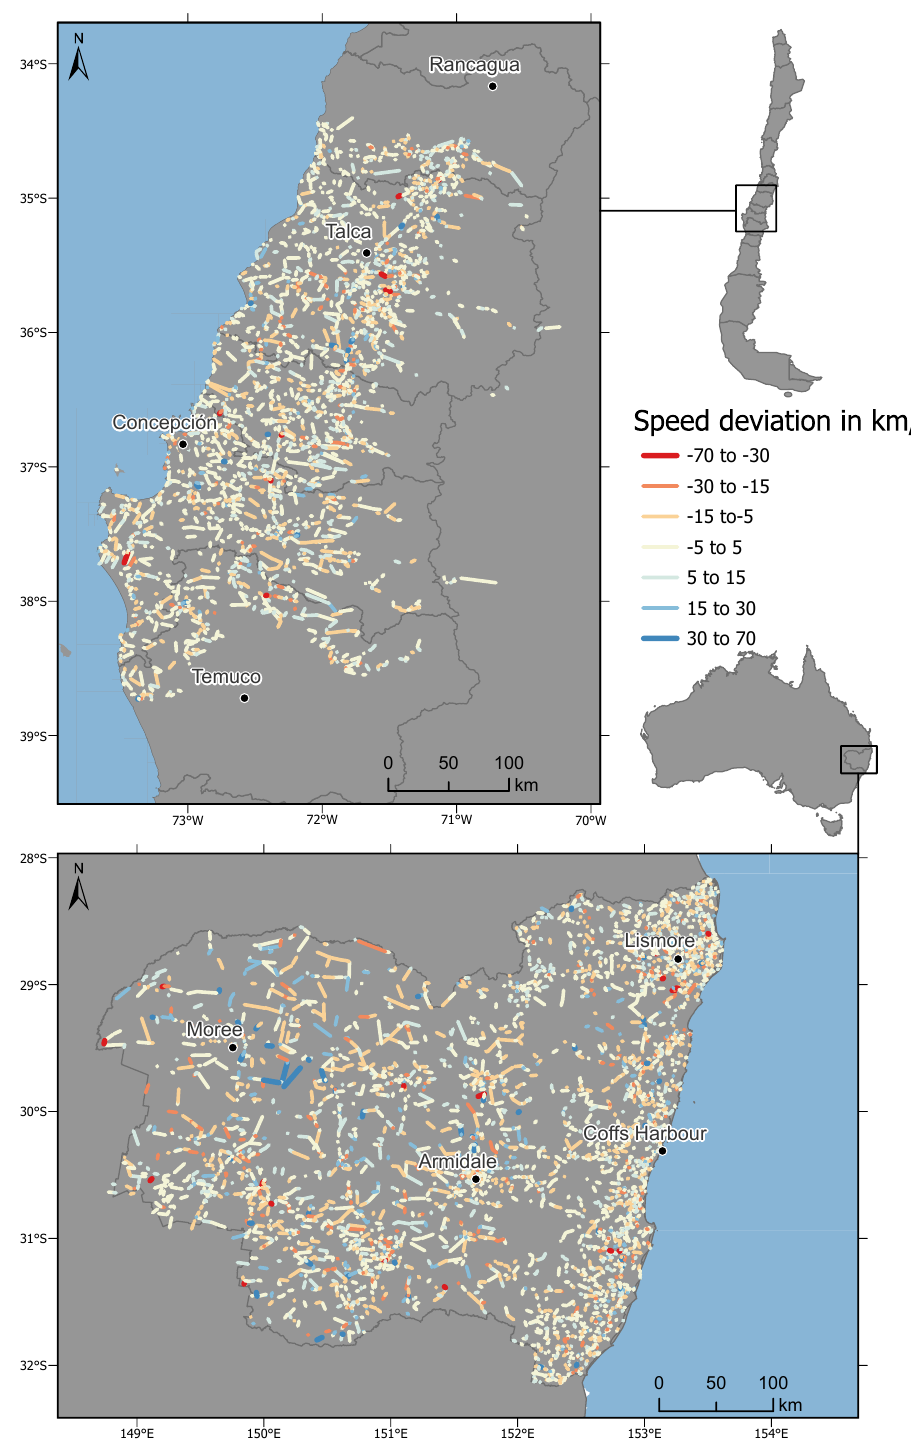
Figure 5. Visualization of the regression results generated by the ET model compared to the reference data extracted by the GD-API on the test subset of the combined dataset. Input features are the OSM road network features (Basic). The speed deviation in km/h between the predicted values and the true values is calculated. Negative values (red and orange) signify lower estimated speed values than reference speed values. The map on the top shows speed deviation of the BM dataset in Chile while the map on the bottom refers to the deviation of the NNSW dataset in